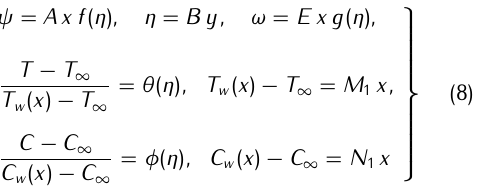
f on Heat Transfer